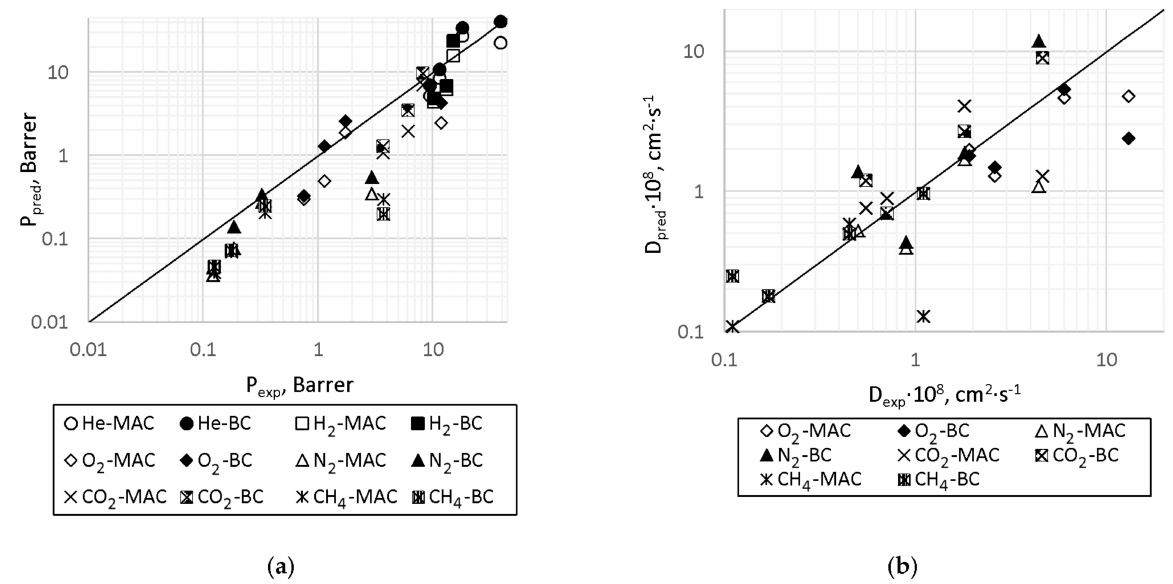
Figure 7. Comparison diagram of predicted and experimental values of permeability coefficient ( a ) and diffusion coefficient ( b ). The solubility coefficients, predicted using the SPCSBP method, are presented in Table 9. These values were compared to the solubility coefficients calculated by the MAC and BC methods (Table 9), as P pred /D pred , where P pred and D pred are the predicted per- meability and diffusion coefficients, respectively, obtained via the MAC or BC methods.